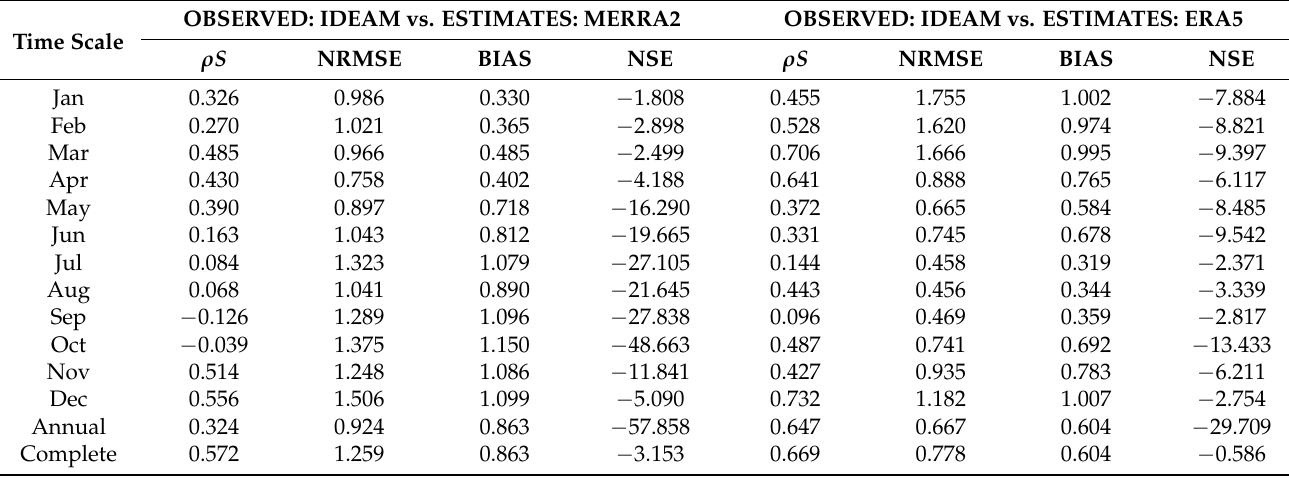
Table 4. Performance results of the tested reanalysis products for average areal rainfall estimations in the Lower Sin ú River basin for